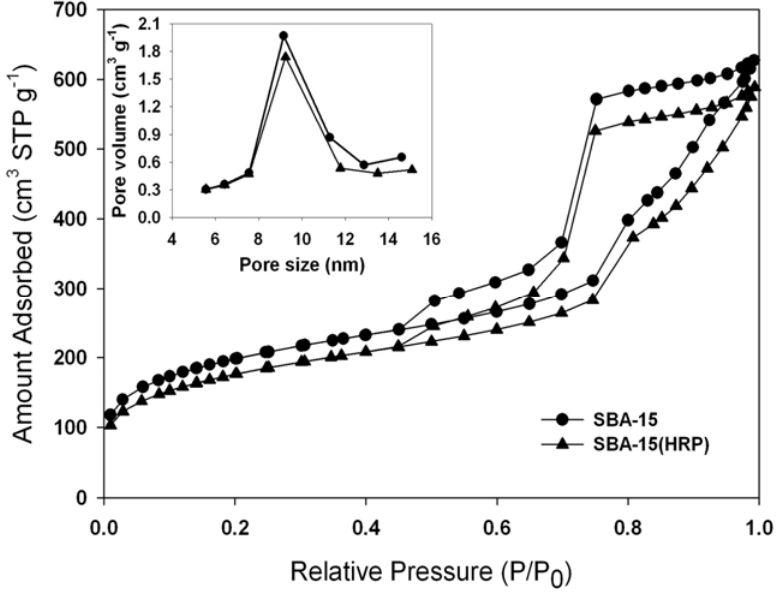
Figure 2. Nitrogen adsorption and desorption isotherms of SBA-15 before ( (cid:122) ) and after ( (cid:83) ) the immobilization of HRP. Inset indicated the pore size distribution of SBA-15 ( (cid:122) ) and SBA-15(HRP) ( (cid:83) ).